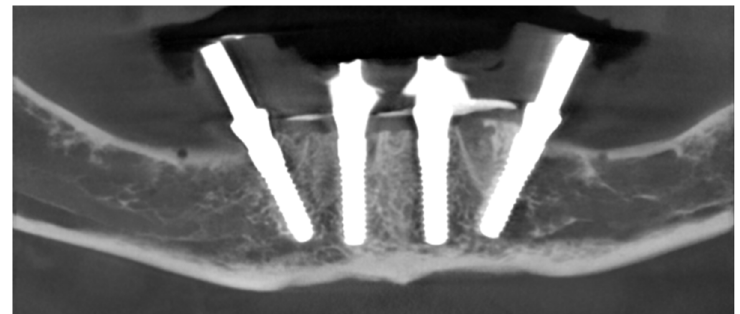
Figure 17. post-op CBCT. Figure 17. Post-op CBCT.